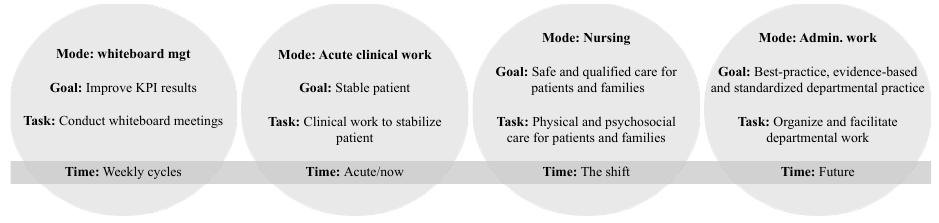
Figure 8. Comparing modes of valuation. Source: Author’s own